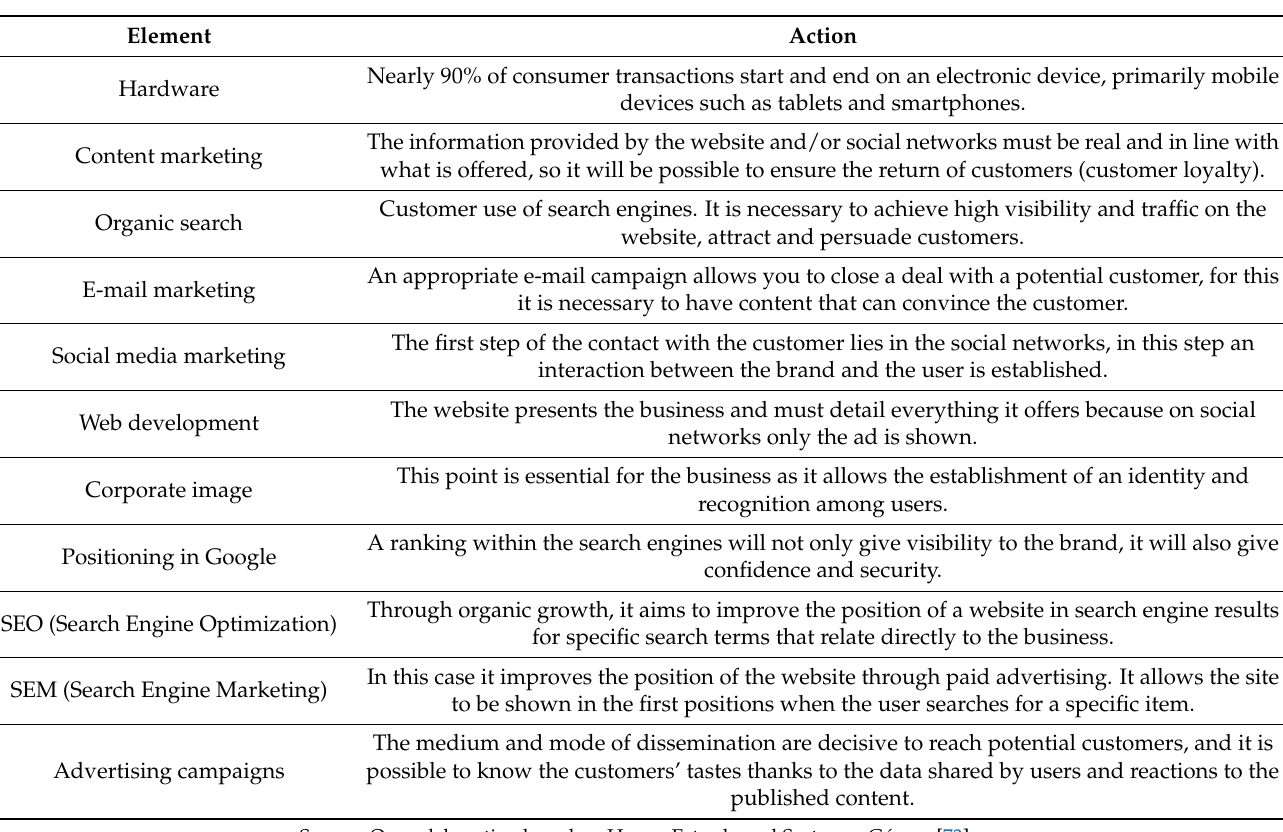
Table 1. Digital marketing